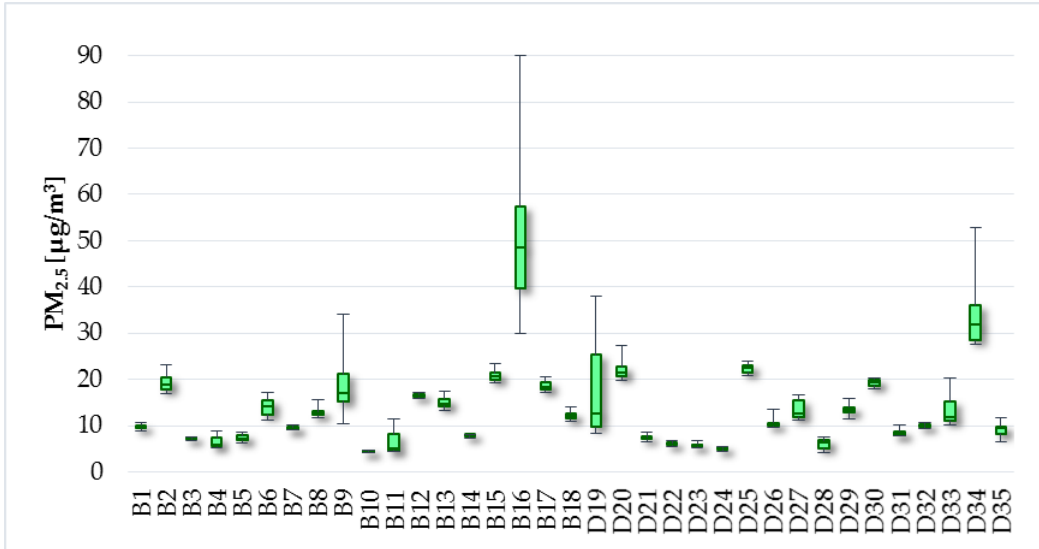
Figure 7. PM 2.5 concentrations.